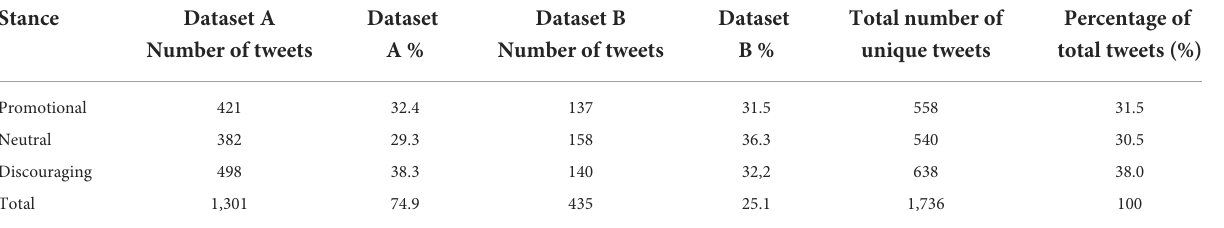
TABLE 2 Dataset after cleaning, 3